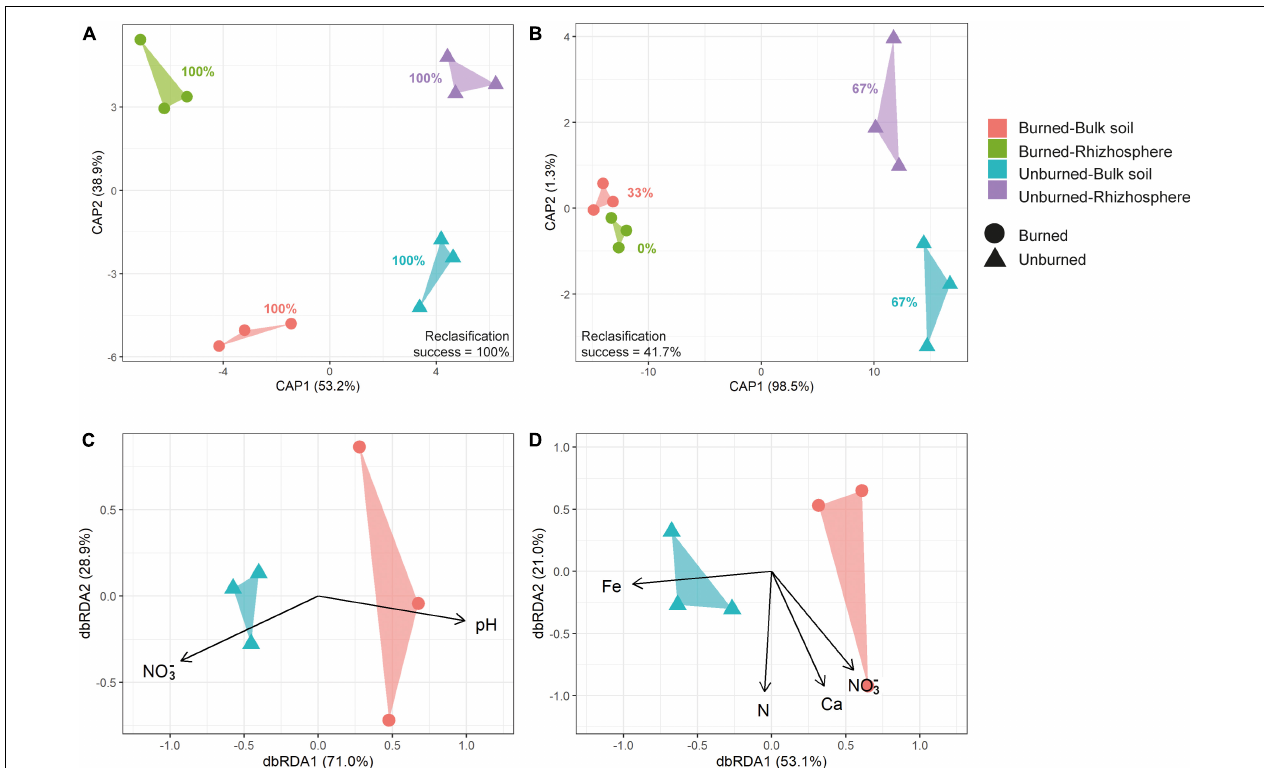
FIGURE 5 | Beta diversity for prokaryotic communities from burned and unburned bulk and rhizosphere soil samples. Canonical analysis of principal coordinates (CAP) based on Bray–Curtis dissimilarities constrained by burned and unburned as well as bulk and rhizosphere soils from Pumanque (A) and Requínoa (B) . The CAP reclassification (in percent) for each treatment is shown next to each cluster. Distance-based redundancy analysis (dbRDA) based on Bray–Curtis dissimilarities constrained by soil physicochemical properties (pH, NO 3 − , and total contents of Fe, N, and Ca) in burned and unburned bulk soils from Pumanque (C) and Requínoa (D) . Soil physicochemical properties (explanatory variables) are shown by solid eigenvectors. PERMANOVA was performed by each site independently ( Table 1